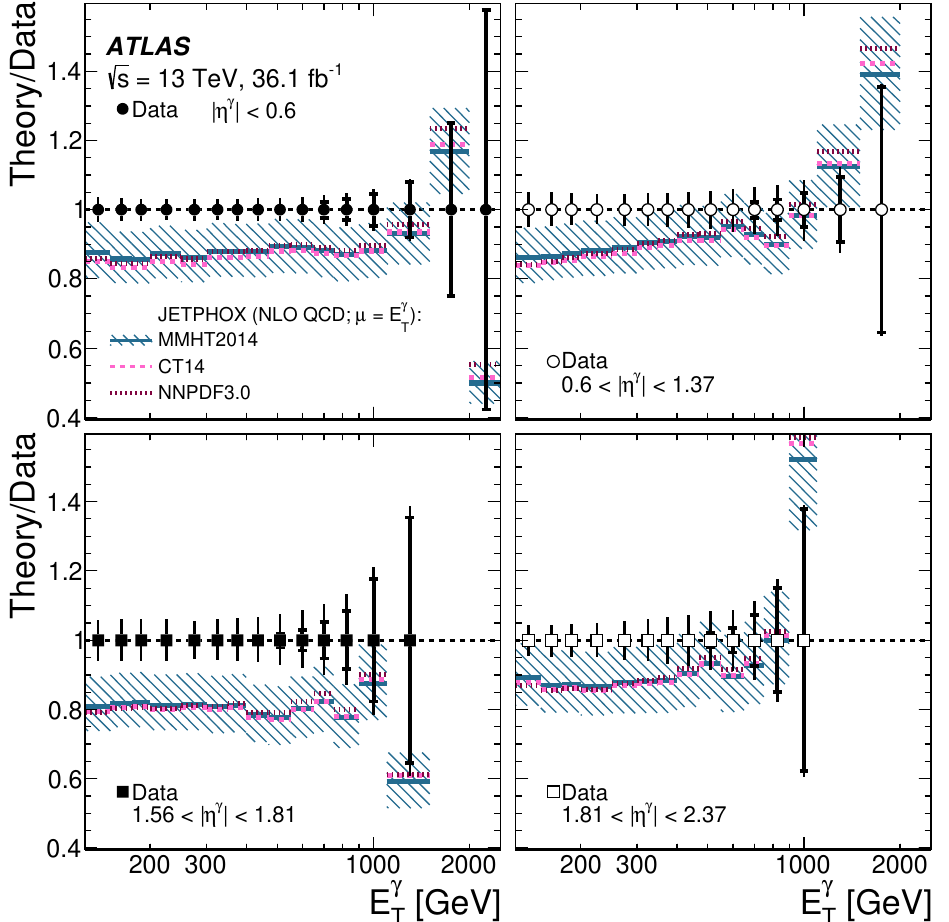
Figure 8 . The ratio of the NLO pQCD prediction of Jetphox with (cid:22) R = (cid:22) F = (cid:22) f = E (cid:13) MMHT2014 PDF set to the measured di(cid:11)erential cross section for isolated-photon production (solid lines) as a function of E (cid:13) in di(cid:11)erent regions of j (cid:17) (cid:13) j . The symbols for the data are centred at unity T and the inner (outer) error bars represent the relative data statistical uncertainties (statistical and systematic uncertainties added in quadrature). The hatched bands represent the full theoretical uncertainty associated to the prediction based on the MMHT2014 PDF set, including the variations of the scales. For comparison, the predictions using the CT14 (dashed lines) and NNPDF3.0 (dotted lines) PDF sets are also